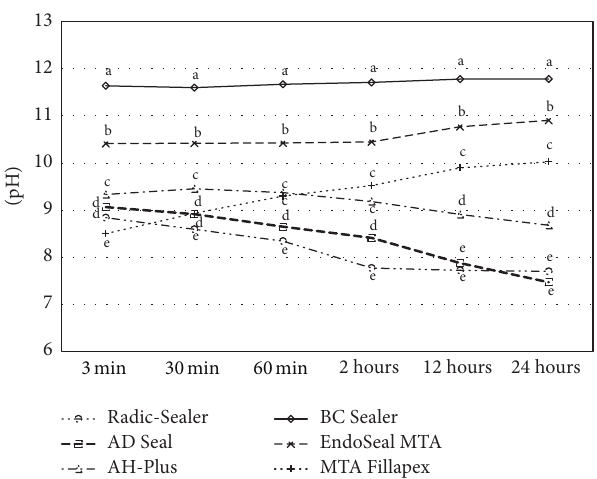
Figure 5: pH change of freshly mixed samples during 24 hours. a , b , c , d , e Different letters present significant difference between sealers at the tested period ( 𝑃 < 0.05